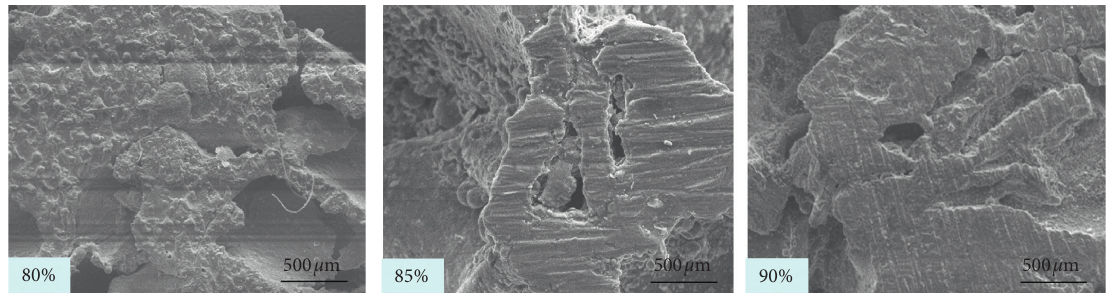
Figure 18: Microstructure of aluminum foam under different